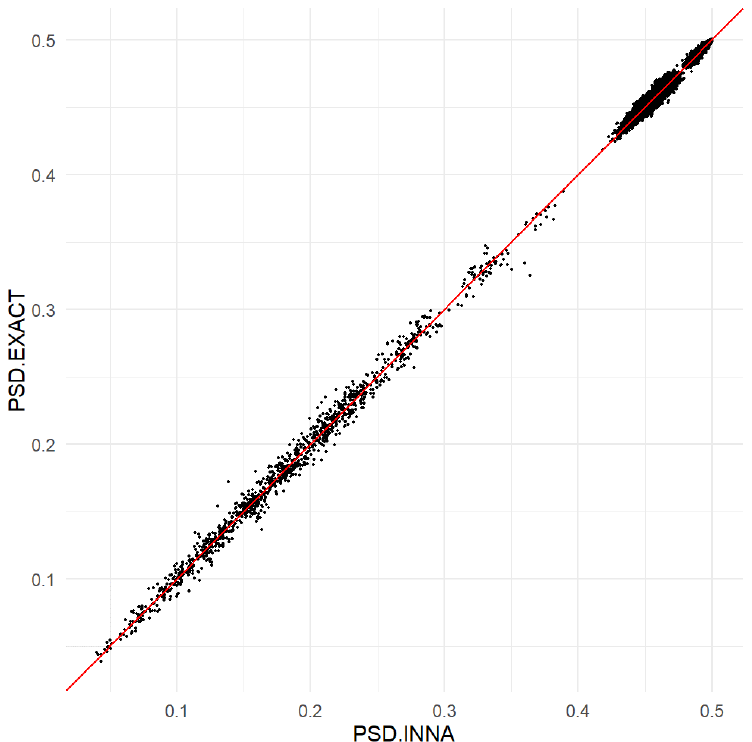
Figure 2. Comparison of the INNA method and the exact method using the PSDs of the household proportions.